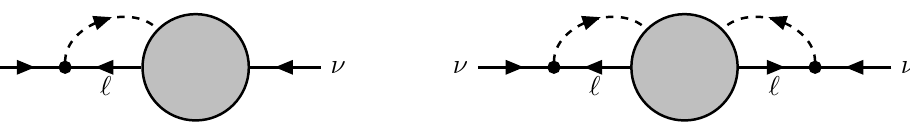
Figure 1 . Self-energy diagram responsible for the generation of neutrino masses via a singly- charged scalar singlet: linear case (left) and quadratic case (right). The grey blob represents all other interactions which contribute to the diagram. It could be one effective vertex or a sub- diagram consisting of multiple vertices and propagators. There are at least two insertions of the Higgs vacuum expectation value somewhere in the diagram which are not explicitly